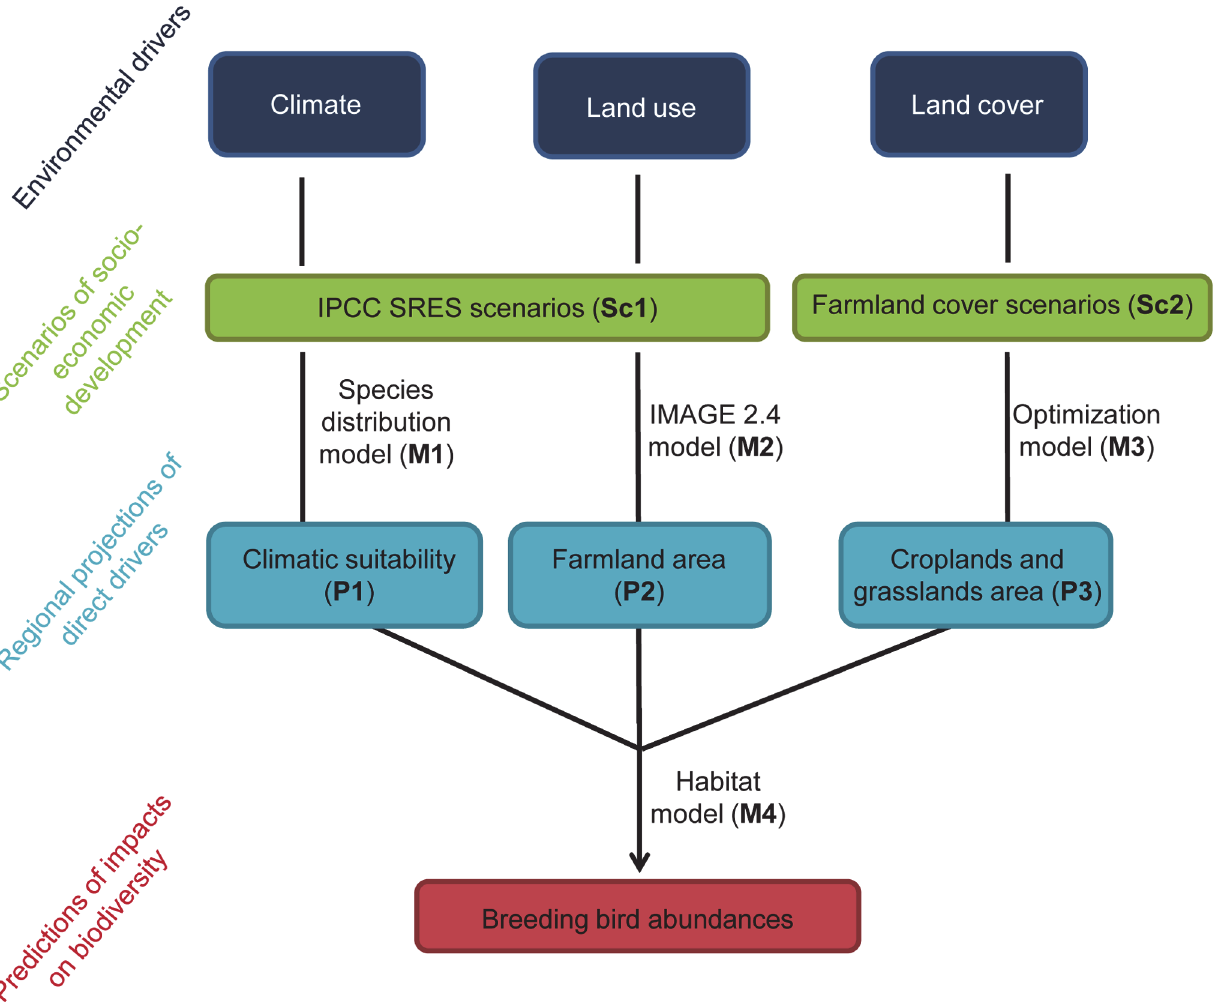
Fig 2. Flowchart summarizing the different steps of the study methods. Overview of the framework to model the effect of climate, land use and land cover changes on farmland bird populations. This flowchart shows how the different environmental drivers, and associated projections (P) derived from various scenarios (Sc), were integrated in our analysis through different methodological tools (M). We used existing scenarios (IPCC-SRES) to derive projections of future climate and land use, while we developed the farmland cover scenarios on the basis of expert judgment to derive projections of future land cover. The regional projections of the three main drivers were then integrated as predictors in a habitat model to forecast changes in breeding bird abundances within French agricultural regions.